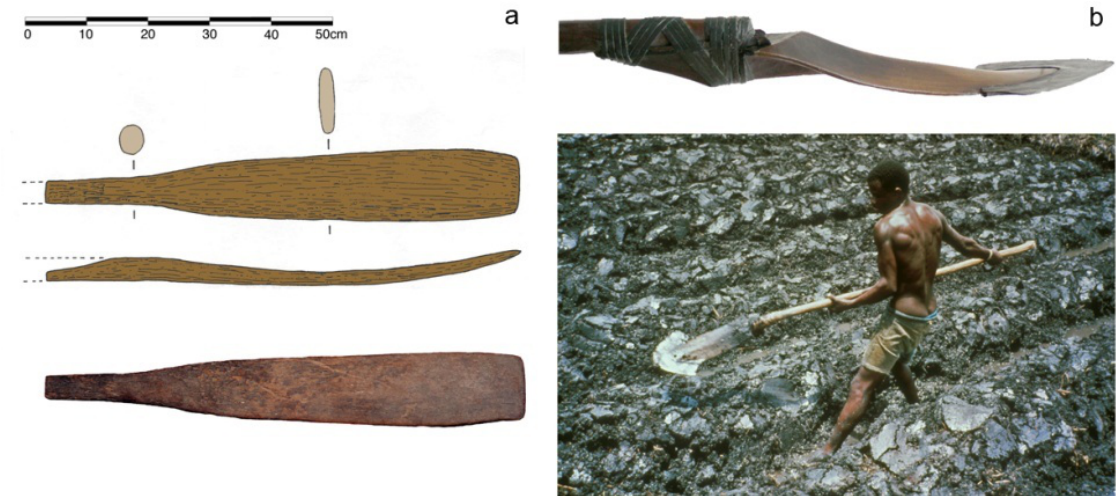
Figure 15. (a) Arauquinoid wooden shovel found near Prins Bernhard Polder (photo and drawing Rostain). (b) Kayendo from Senegal used to build raised fields by Floup group (photos